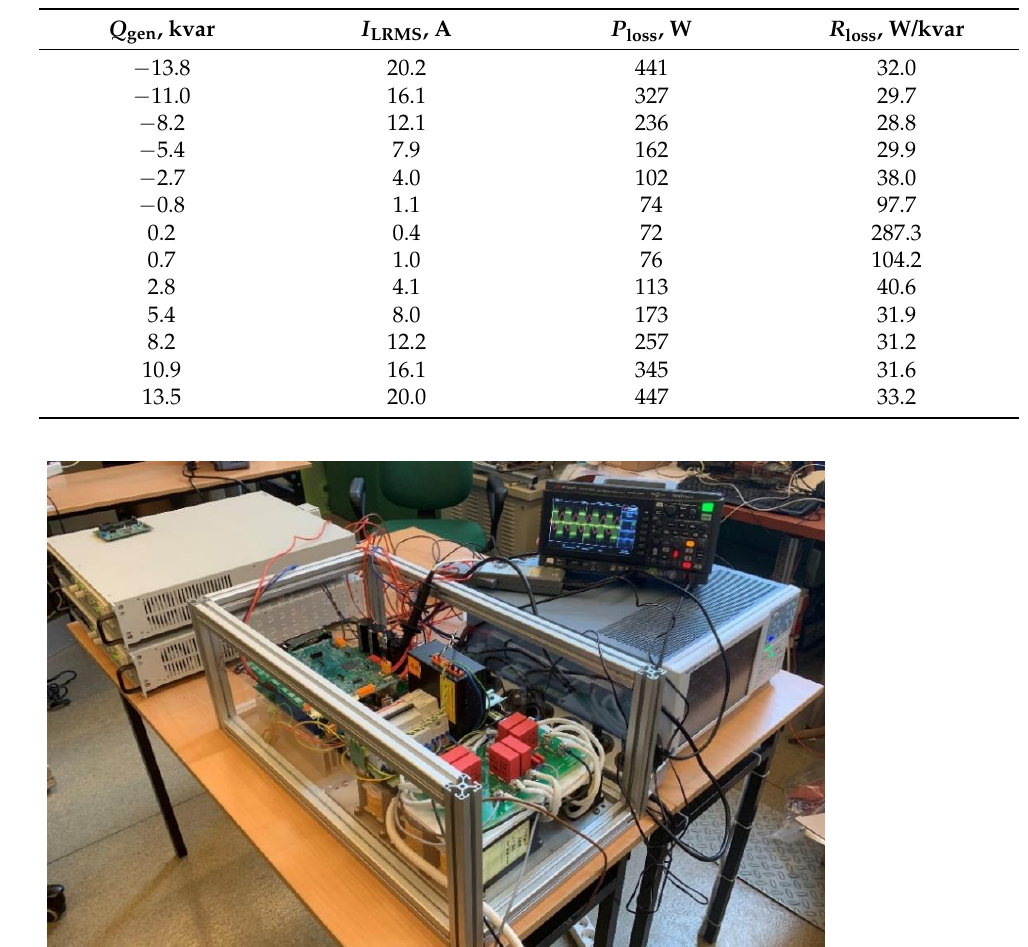
Figure 9. Per kvar power losses measured during the reactive power generation mode. Exemplary results of the operation of the APF during reactive power generation is presented in Figure 10. The results were been obtained using analyzer WT5000. On the left-side, plots of the measured voltages, currents, and powers are presented. On the right- side, plots of the current and voltage waveforms are presented. One can see that the grid voltages are distorted, which caused slight current distortions. Despite these distortions, the phase shift angles between the current and voltage in each phase are satisfactory, and it is also visible that the reactive powers are balanced.